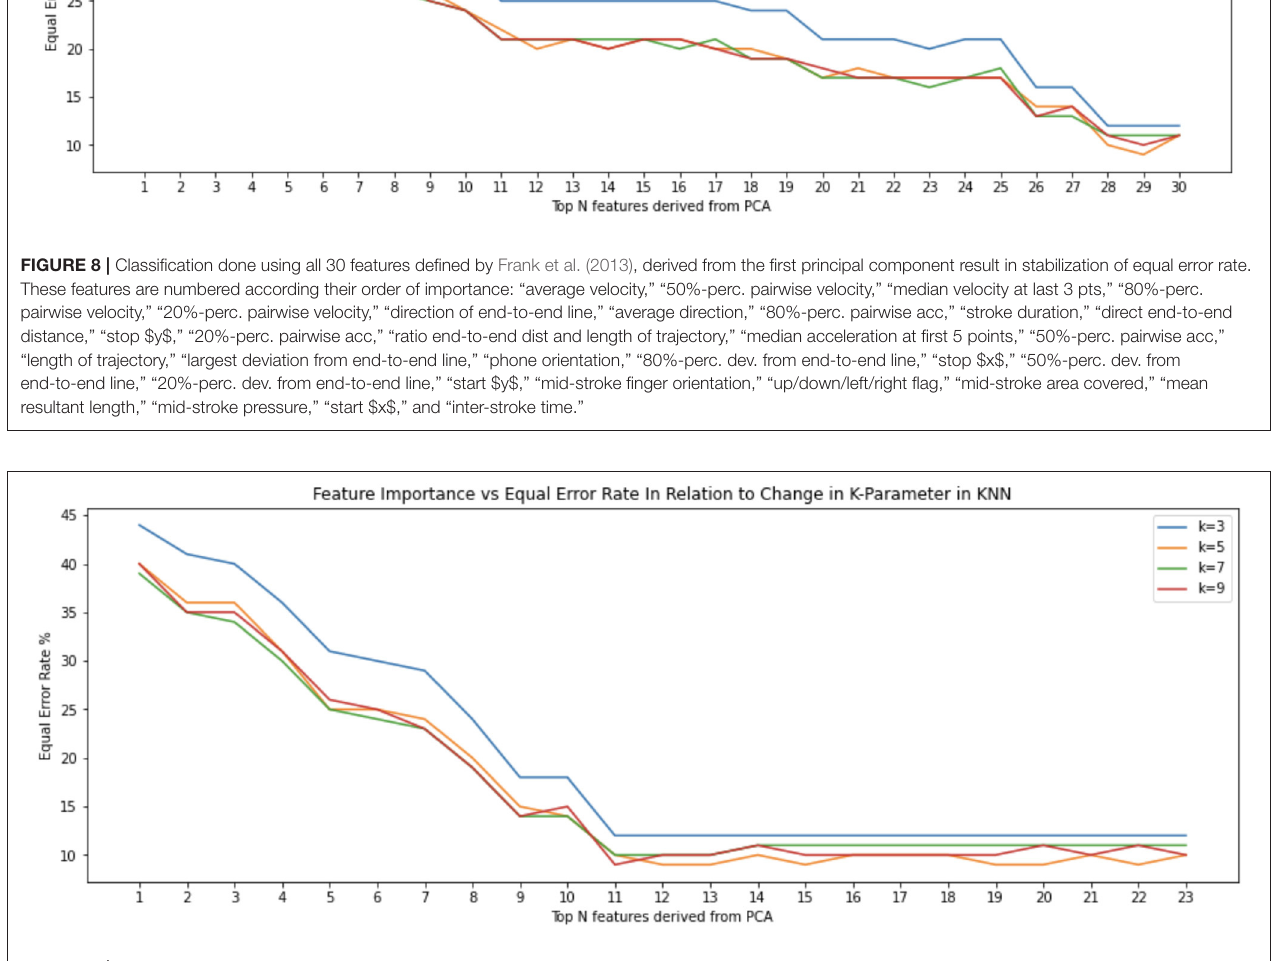
FIGURE 9 | Classification done using the 23 features derived from the top 30 principal components result in a more pronounced stabilization of equal error rate. These features are numbered according to their order of importance are: “average velocity,” “largest deviation from end-to-end line,” “50%-perc. pairwise acc,” “length of trajectory,” “start $y$,” “mean resultant length,” “up/down/left/right flag,” “start $x$,” “mid-stroke area covered,” “inter-stroke time,” “mid-stroke pressure,” “mid-stroke finger orientation,” and